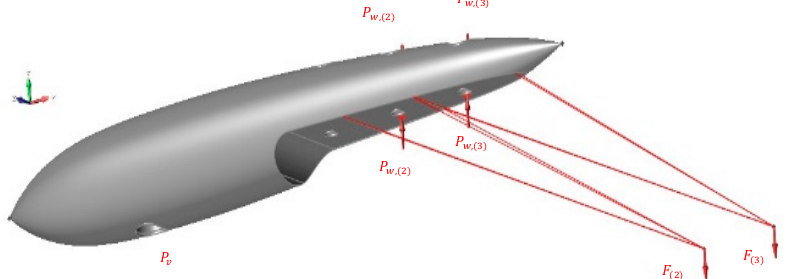
Figure A3. Capsize (clockwise, l ) load case, constraints are hidden for representation. The overall longitudinal length of the component is 290 mm .